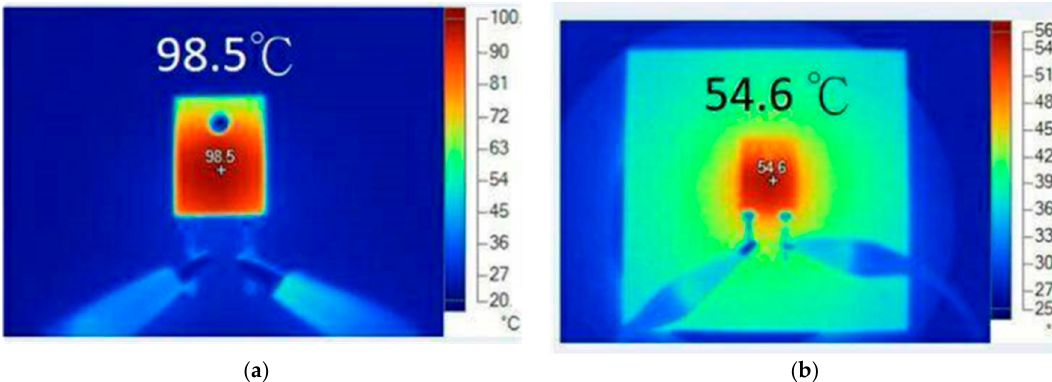
Figure 9. Temperature field of the heating single chip. ( a ) Original single chip temperature. ( b ) Pasted graphene composite TIM (MSA13050).